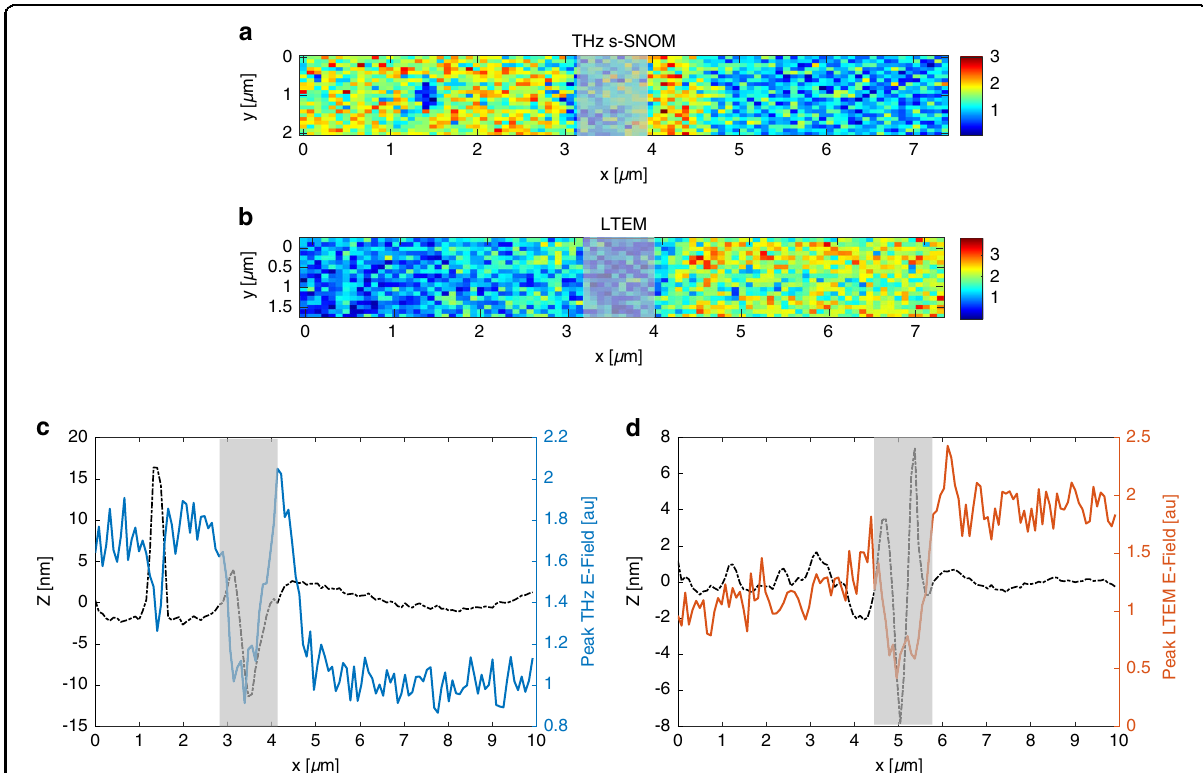
Fig. 4 THz s-SNOM and blue light LTEM near- fi eld images across implant boundary. a 2D THz s-SNOM image across the substrate/implant boundary, modulated at the 3rd harmonic of the tapping frequency. b LTEM image across the same boundary. c Average line pro fi le from THz s-SNOM image in ( a ). d Average line pro fi le from LTEM image in ( b ). Gray shaded regions mark boundary region where there is signi fi cant